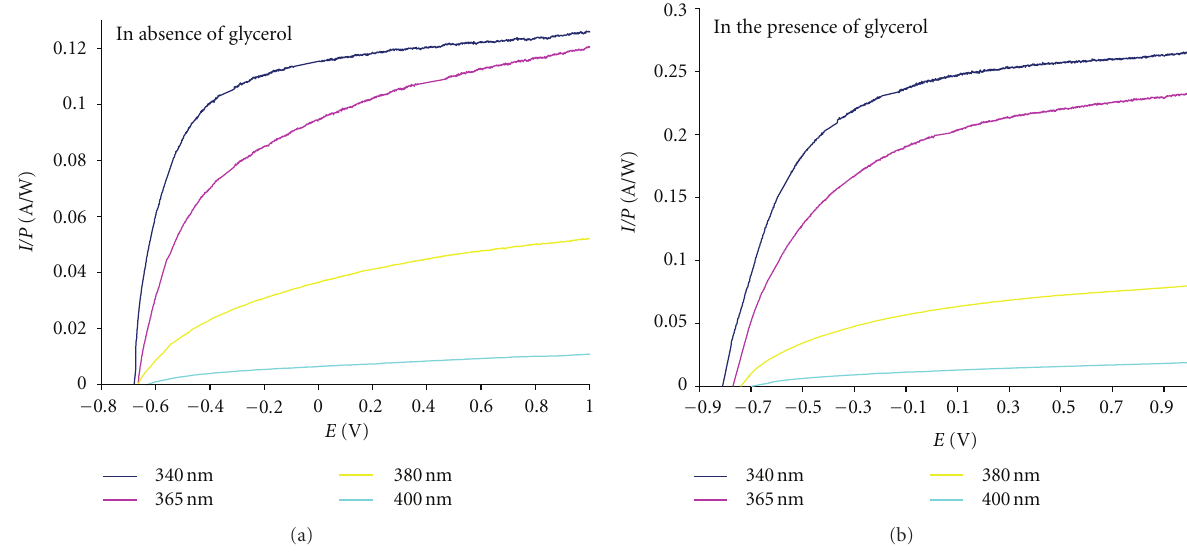
Figure 1: Trend of photocurrents (normalized to incident power light) versus potential, at di ff erent wavelengths, in absence and in presence of